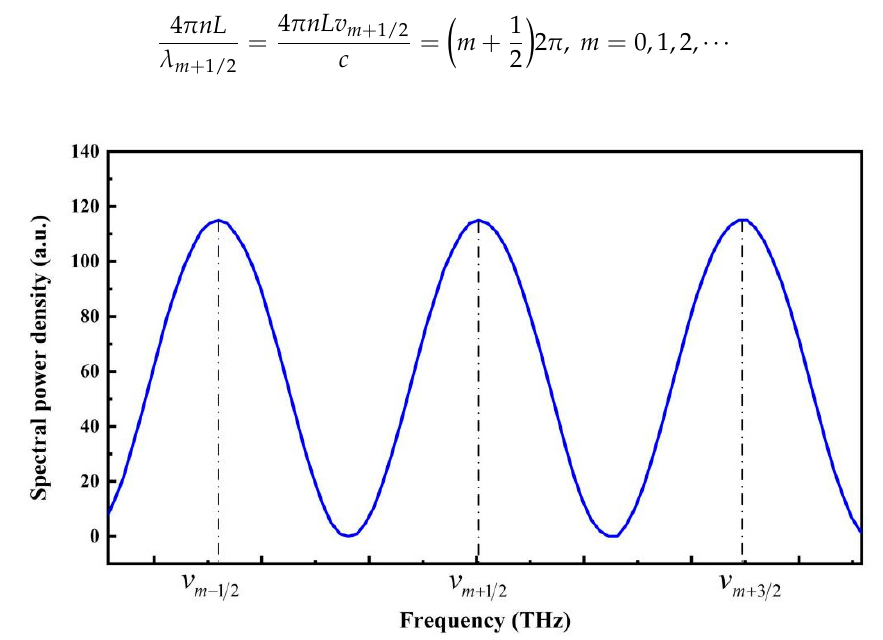
Figure 2. Typical reflection spectrum of a fiber-optic FP sensor in the optical frequency domain, in which, v m − 1/2 , v m + 1/2 , and v m + 3/2 represent the optical frequencies of three successive reflection peaks, and m is an integer related with the orders of the reflection peaks.